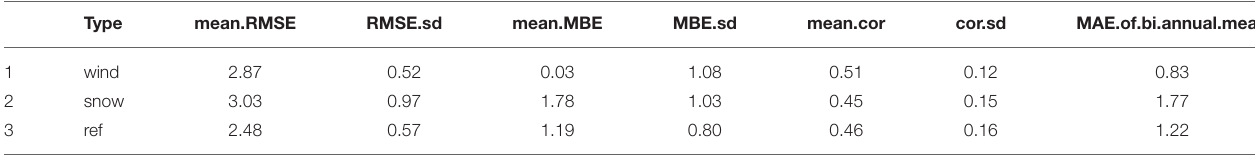
TABLE 1 | COSMO-1 validation against IMIS stations, for wind-exposed “wind” stations, wind-sheltered “snow” stations and reference stations. Type